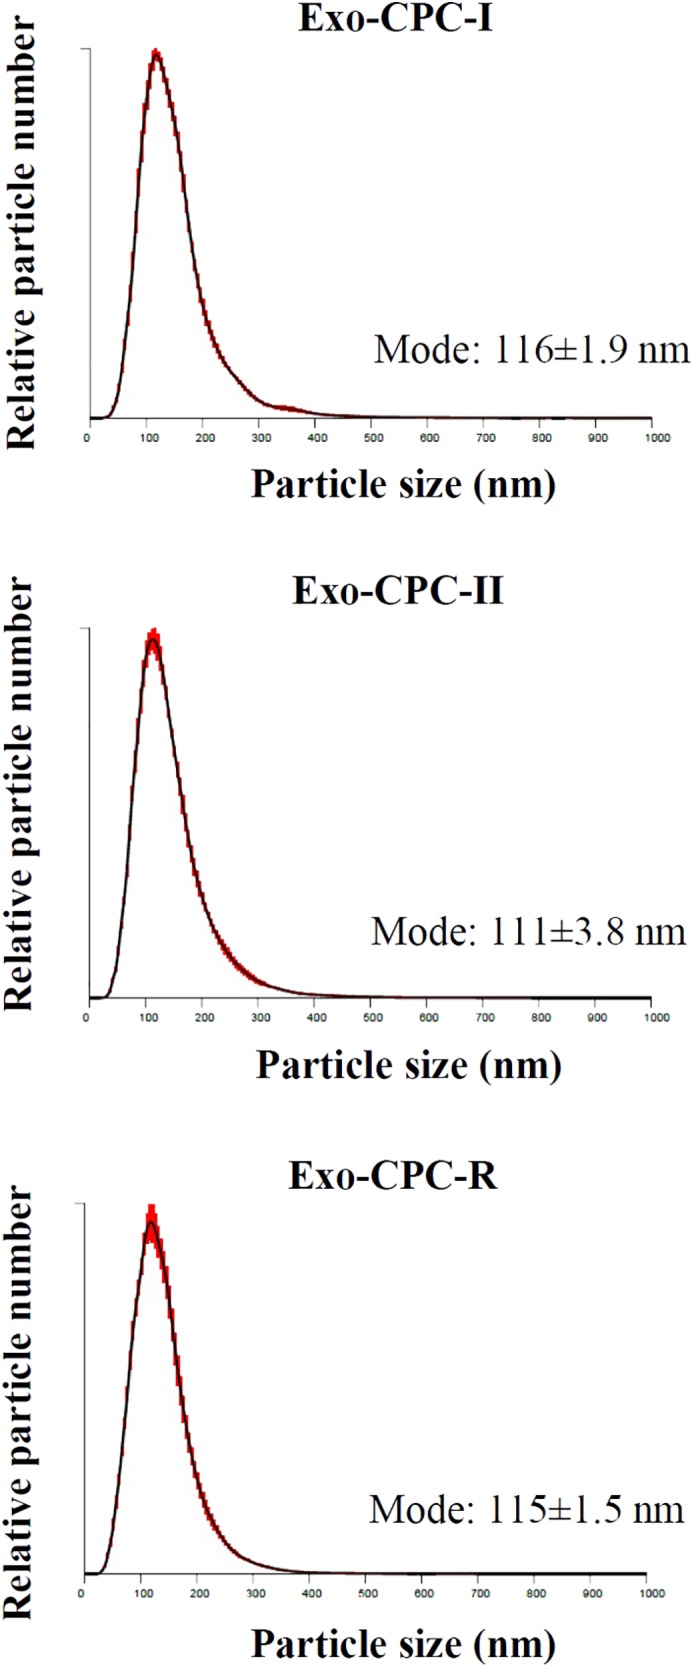
NTA profiles of Exo released by CPC cultured in different conditions. Size distribution graphs of the Exo from CPC expanded in GMP and research conditions. Red error bars indicate ±1 standard error of the mean. The mean ± standard error (n = 5) of the distribution modes from each replicate are shown.